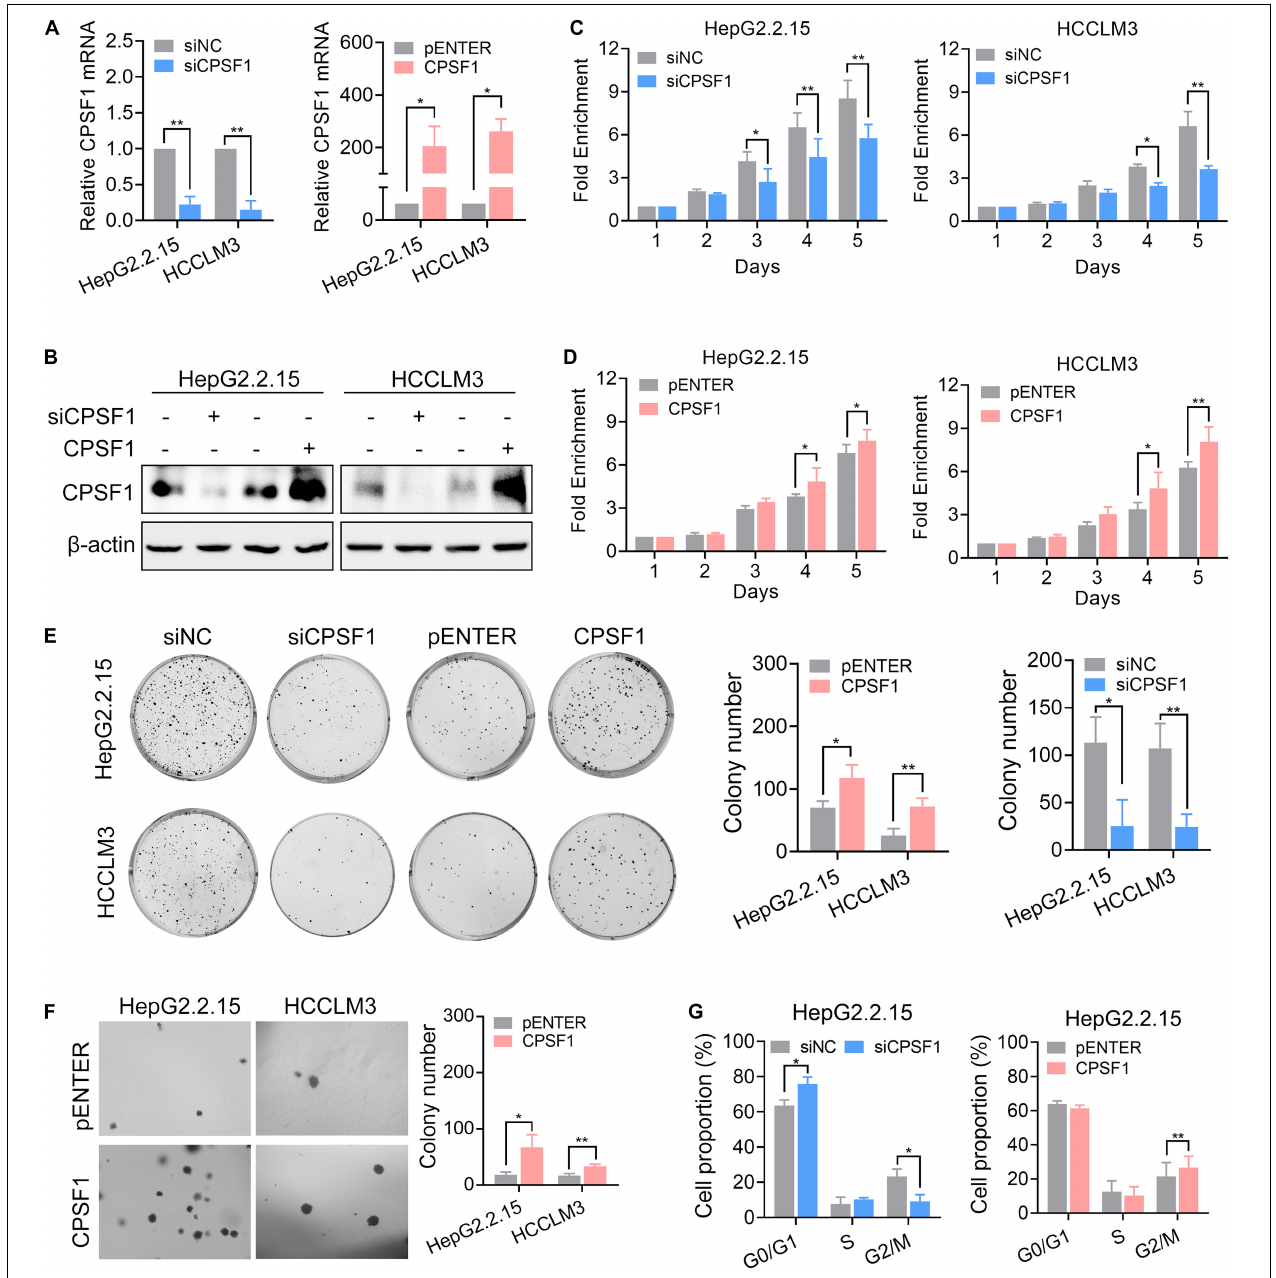
FIGURE 3 | CPSF1-depletion inhibits HCC proliferation and migration. CPSF1 was knocked down or overexpressed in HepG2.2.15 and HCCLM3 cells. The mRNA and protein levels of CPSF1 were determined by qRT-PCR (A) and western blot (B) , respectively. Statistical significance was calculated by one sample Student’s t -test. Cell proliferation in the (C) CPSF1-silenced or (D) CPSF1-overexpression groups was detected using the CCK8 assay over five consecutive days. The relative absorbance was measured at OD 450 . Fold enrichment was normalized to the absorbance on day 1 and assessed by ANOVA. (E) Colony formation assays were used to determine the effect of CPSF1 on cell growth in the indicated groups. The number of colonies was counted using ImageJ software (NIH, Bethesda, MD, United States) and analyzed using Student’s t -test. (F) Anchorage-independent assays showing that overexpression of CPSF1 promotes colony formation in HepG2.2.15 and HCCLM3 cell lines. (G) Flow cytometry assays were used to determine the percentage of cells in various phases of the cell cycle following CPSF1 knockdown or overexpression. Statistical data were assessed using two-way ANOVA. Statistical data are presented as mean ± SD. * P < 0.05 and ** P < 0.01.